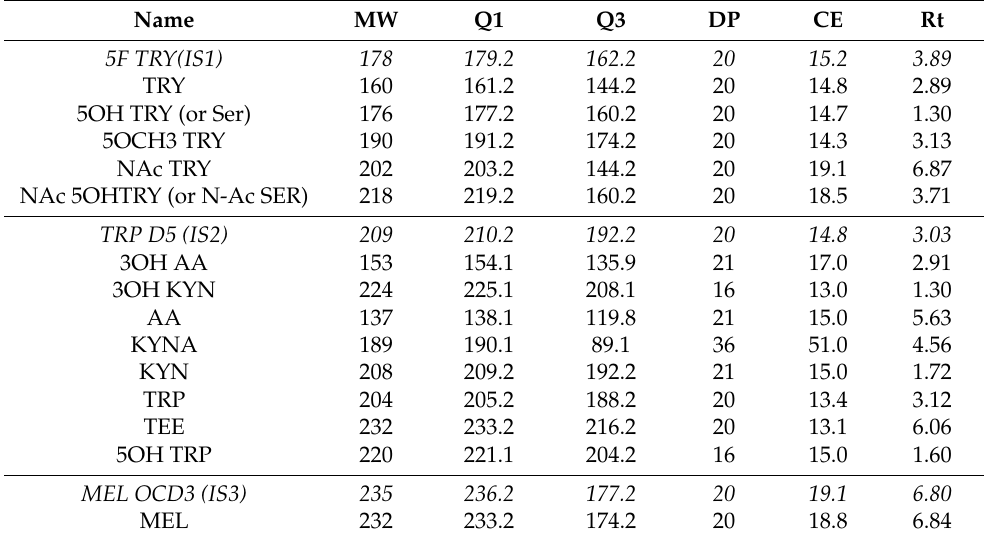
Table A1. MRM transitions for LC-MS/MS analysis of indolic species. Each subclass is preceded by the correspondent IS (in italics) used for